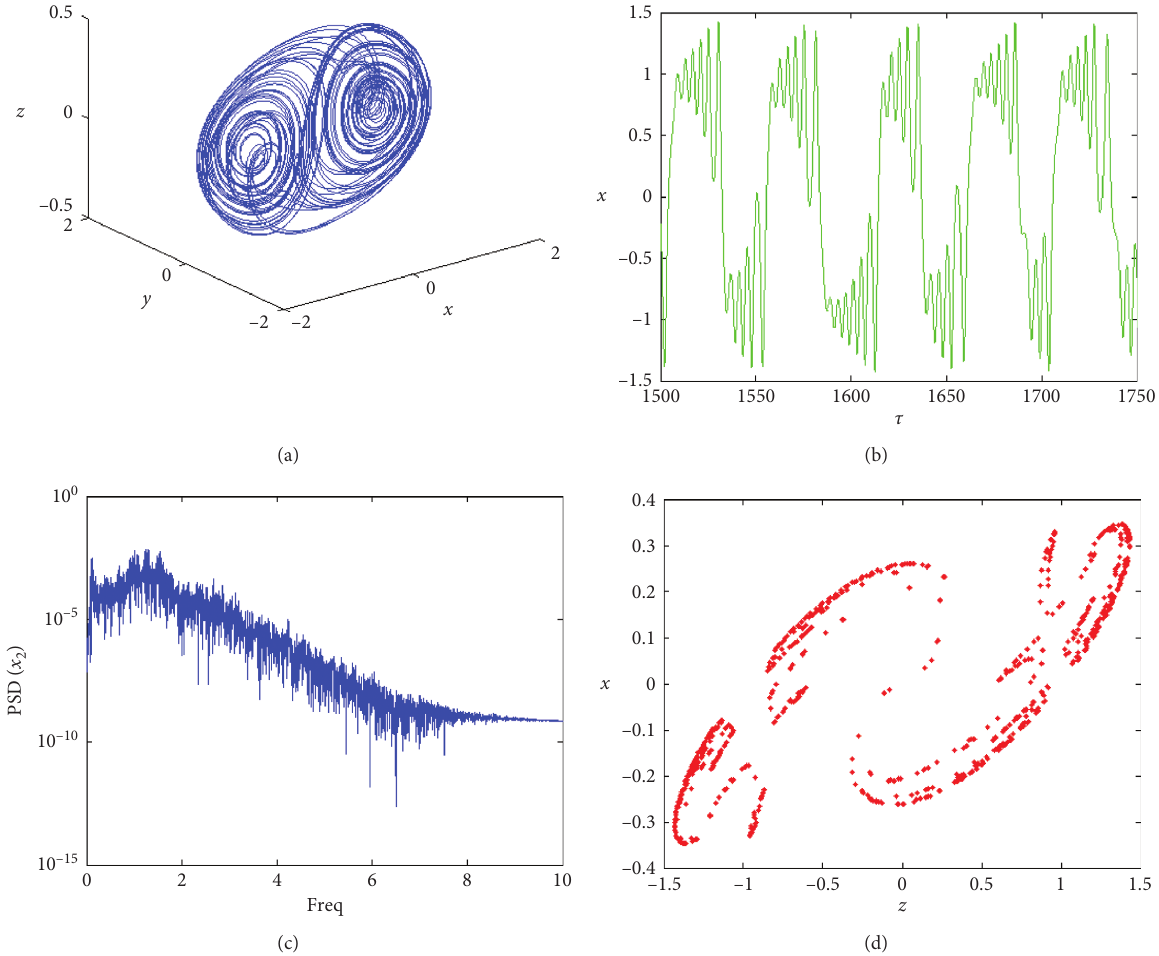
Figure 4: Three-dimensional portrait (a), time series (b), frequency spectrum (c), and Poincar´e section (d), confirming symmetric chaotic behavior of the system for m � 0 . 00 and b � 0 . 32. The other parameters are specified in the text.